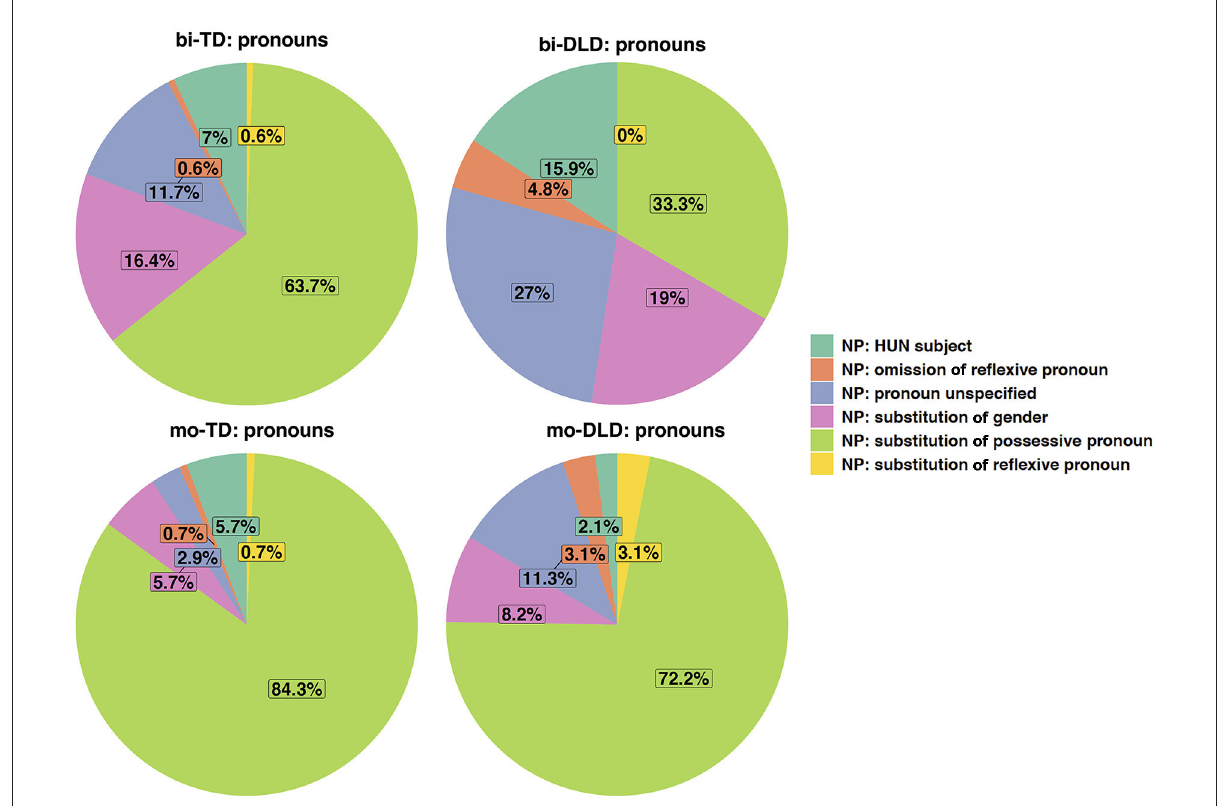
FIGURE6 Distributions of pronoun errors in Dutch in the bi-TD, bi-DLD, mo-TD, and mo-DLD